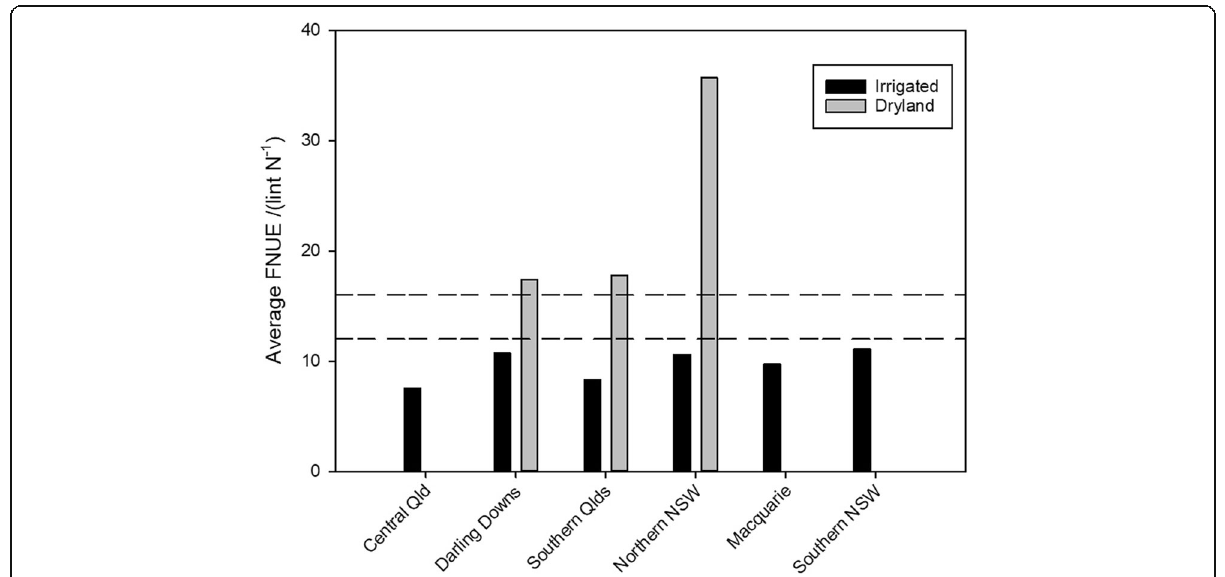
Fig. 3 Average NFUE for six Australian cotton growing regions during the 2012 – 2013 season. The dash lines represent the optimum NFUE determined by Rochester (2014). Data sourced from Roth Rural (2014)